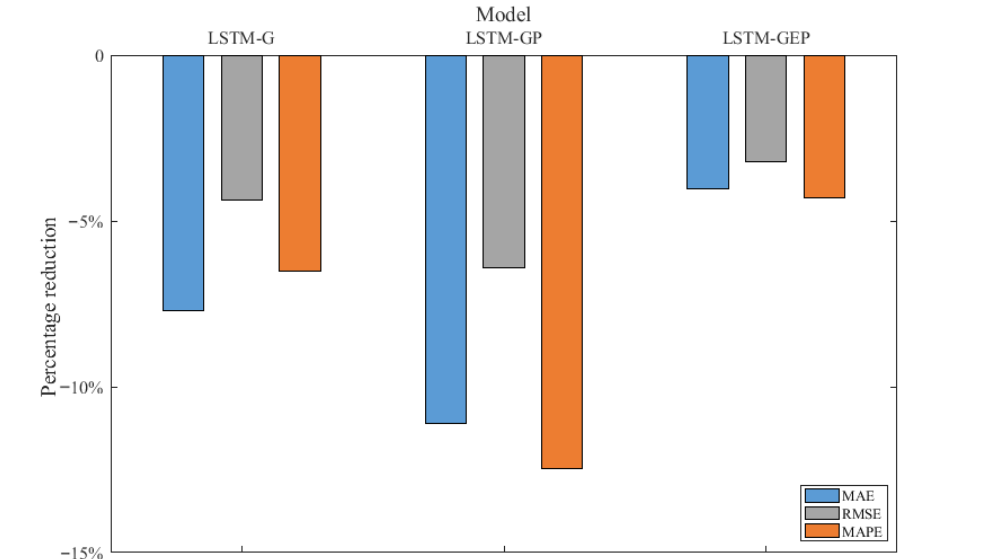
Figure 8. Comparison of MAE, RMSE, and MAPE between the combined models and LSTM